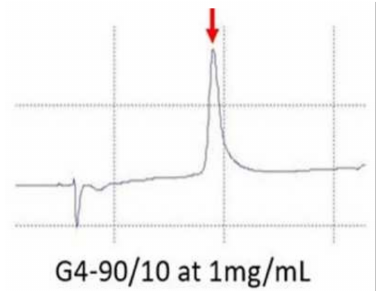
Figure 4. RP-HPLC of G4 90/10-Cys. The peak (red arrow) observed during RP-HPLC confirms that the synthetized dendrimer is pure and